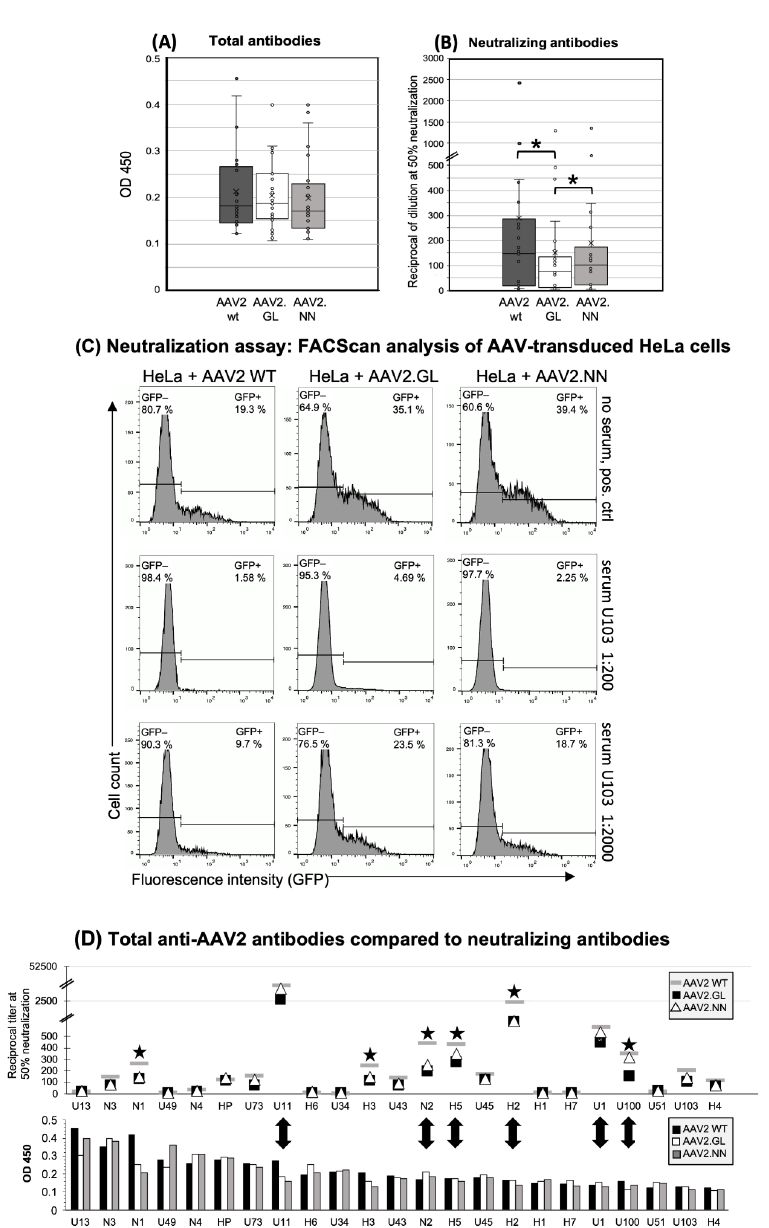
Figure 1. Human antibody responses to AAV2 WT, AAV2.GL, and AAV2.NN capsids. ( A ) Total Ig antibody responses (IgM, IgG, IgA) to the AAV capsids calculated from the ODs of all samples at a